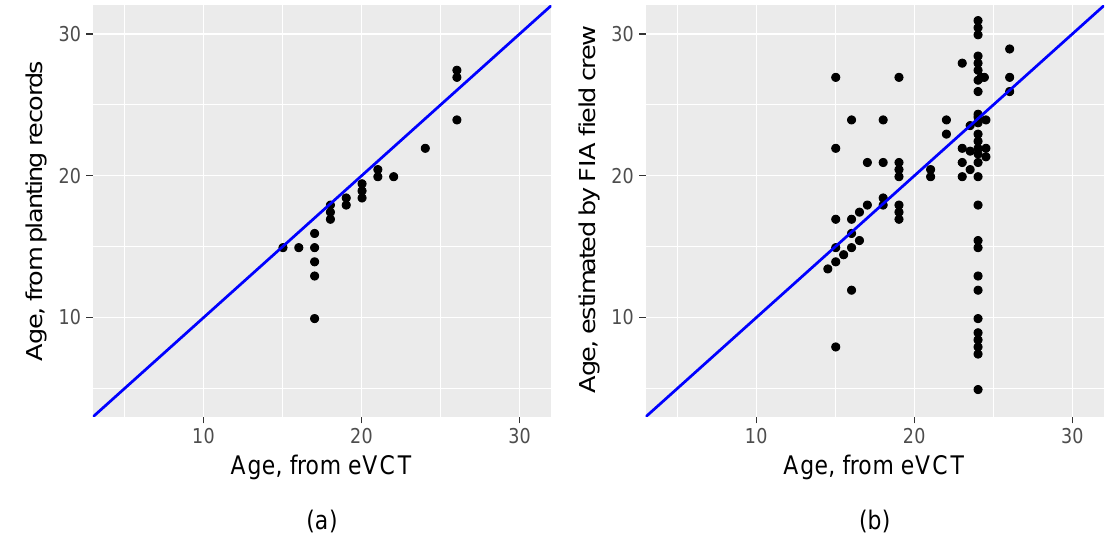
Figure 10. Correspondence between forest stand ages predicted by eVCT and estimated from other ground-truth sources (all ages are in years). The 1:1 line is shown in blue. Only plots that were indicated by eVCT to be 15 years of age or above were examined. Some points in the plot have been slightly jittered ( ≤ 0.5 years) so that points do not lie on top of each other. ( a ) Age agreement, using quality-adjusted planting record data from the Appomattox-Buckingham State Forest plot set (23 plots, see Section 2.5). One extreme outlier point at ( x , y ) = (10, 72) is excluded. It can be seen that most points are near the 1:1 line. The bias is − 1.1 years. Around 87% of plots have ± 3 years age agreement while 91.3% of plots have ± 5 years, ( b ) Age agreement, using the set of 75 FIA plots. The pronounced “vertical line” of points corresponding to eVCT age = 24 is most likely due to VCT being less reliable at the beginning of the time series, see text for more details. The overall agreement is much weaker in this case. The bias is rather small (1.1 years). Around 65.3% of plots have ± 3 years age agreement, 73.3% of plots have ± 5 years and 85.3% have ± 8 years.